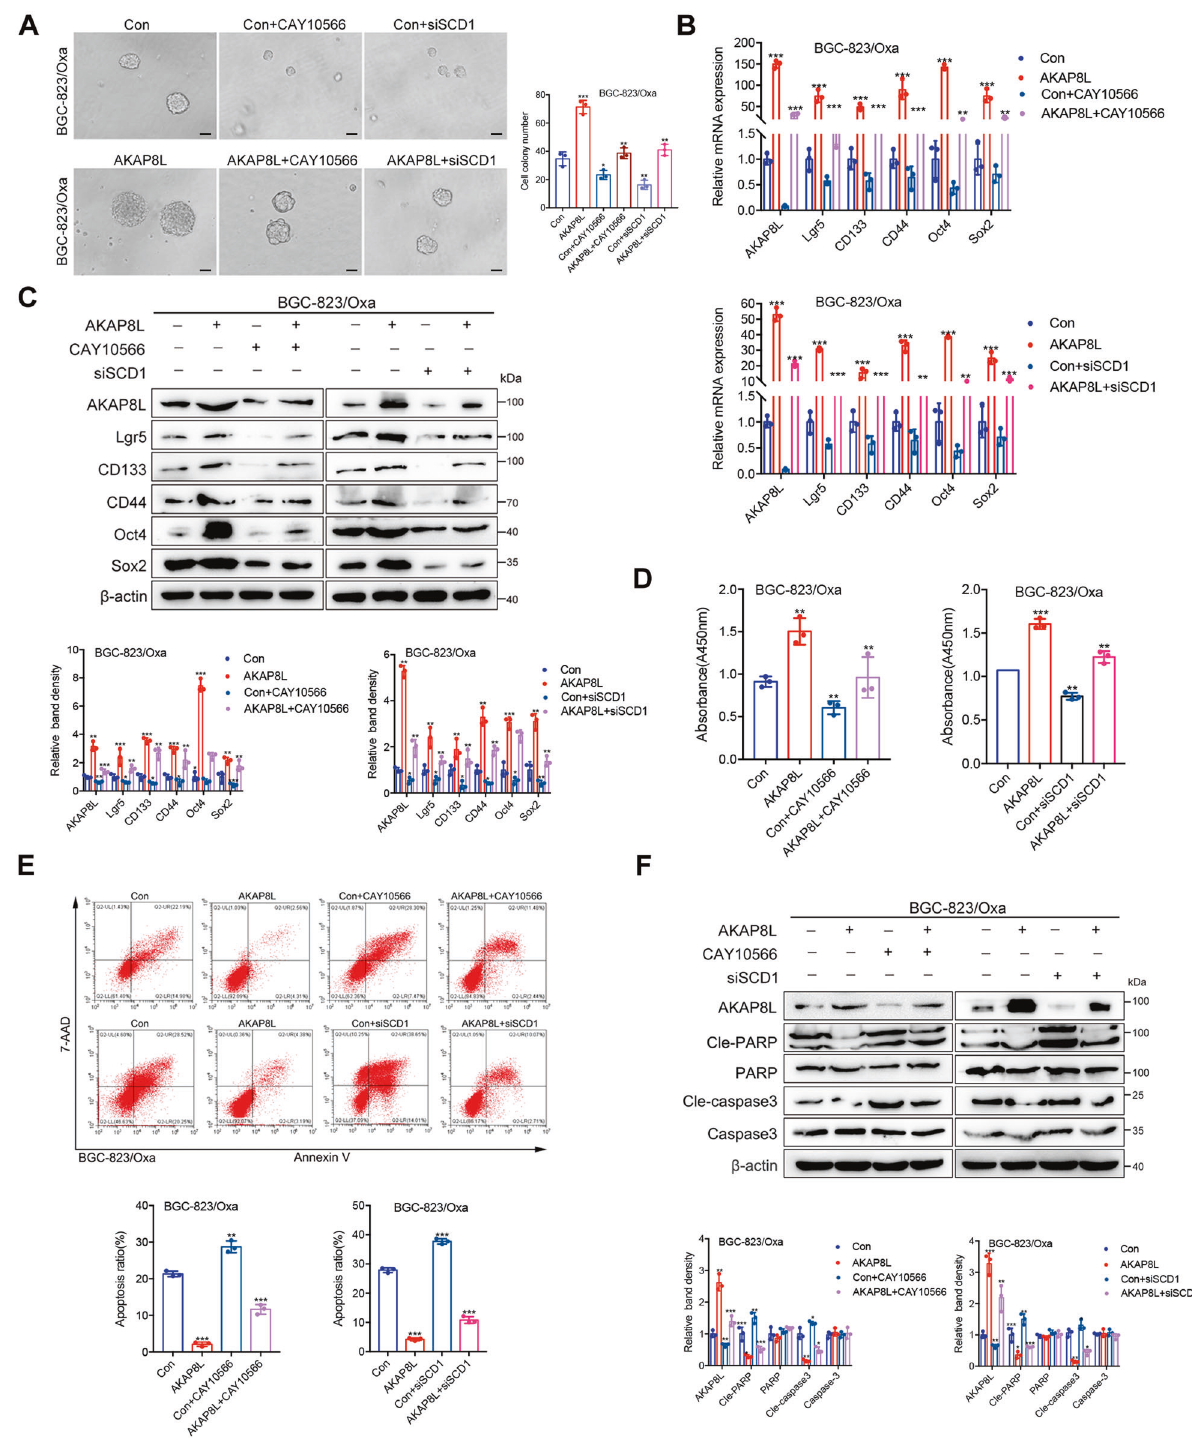
Fig. 7 SCD1 mediates the effects of AKAP8L on GC cell stemness and chemoresistance. SCD1 siRNA was transiently transfected to AKAP8L overexpressing cells. SCD1 inhibitor (CAY10566) was added into AKAP8L overexpressing cells. A Representative images of spheroids in the SCD1 inhibitor, AKAP8L, AKAP8L/SCD1 inhibitor and the control groups. B , C qPCR and Western blot assays showed the stemness-related gene expression induced by AKAP8L/CAY10566 or AKAP8L/si-SCD1. D Cell viability was measured by MTT in four groups after the treatments of Oxa. E Representative images of fl ow cytometry showed the percentage of apoptotic cells in four groups after the treatments of Oxa. F Western blot analysis of cleaved-caspase 3 and cleaved-PAPR induced by AKAP8L/CAY10566 or AKAP8L/si-SCD1. Scale bar indicates 50 μ m. The values indicate the mean ± SD of three independent experiments. * P < 0.05, ** P < 0.01, *** P < 0.001.